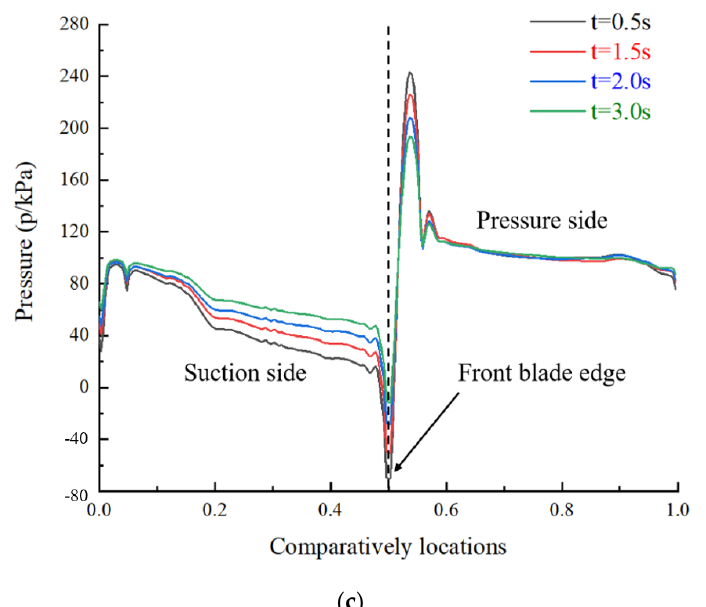
Figure 12. Pressure characteristics at different span lines under deceleration: ( a ) span = 0.1; ( b ) span = 0.5; ( c ) span = 0.9.